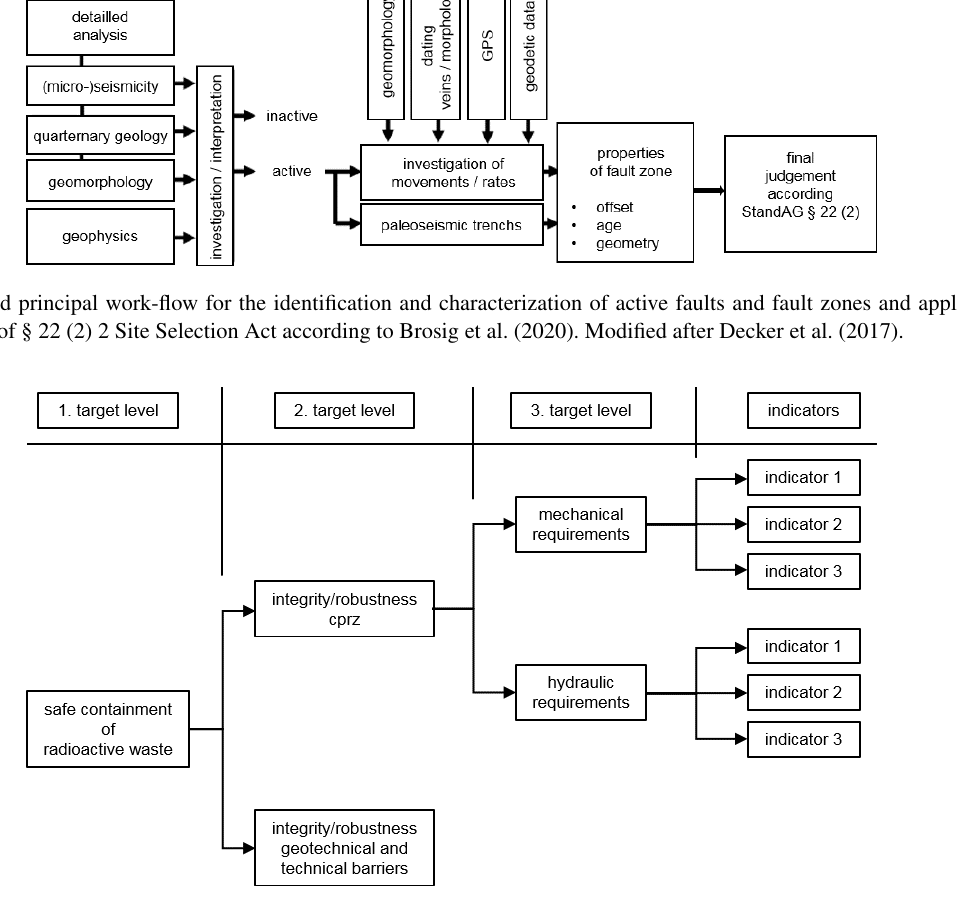
Figure 3. Splitting of a multi-criteria problem into different, hierarchical target levels and finally indicators. Aggregation of data and results is done on the different target levels. After Frieling et al.